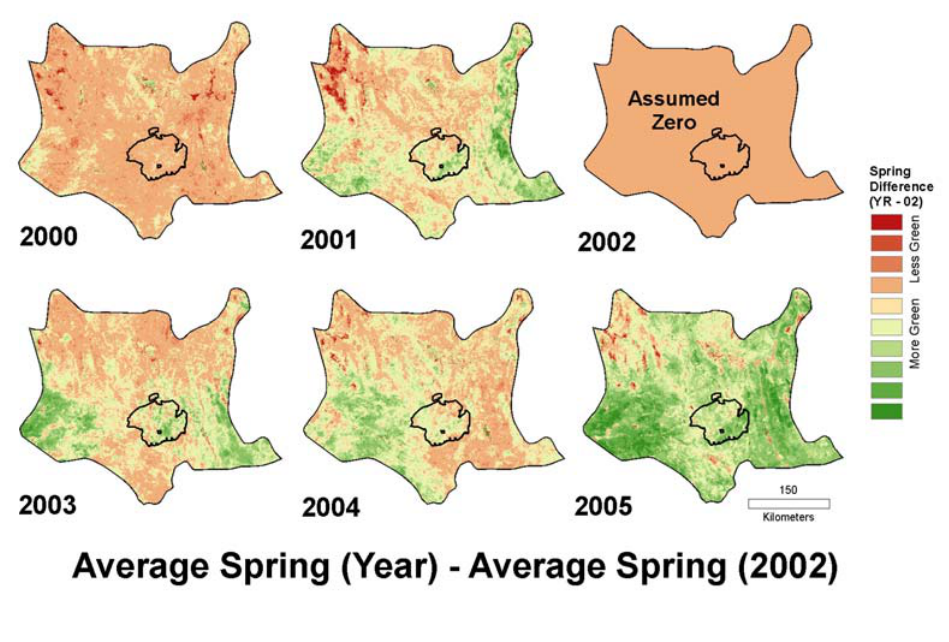
Figure 7. Annual growth models for 2000 to 2005 represented by the best performing metric Average Spring (Year) - Average Spring (2002). The gradual color ramp of pink to green represents low to high annual growth. These are created by assuming the spring annual plant cover for 2002 (an extremely dry year) was essentially